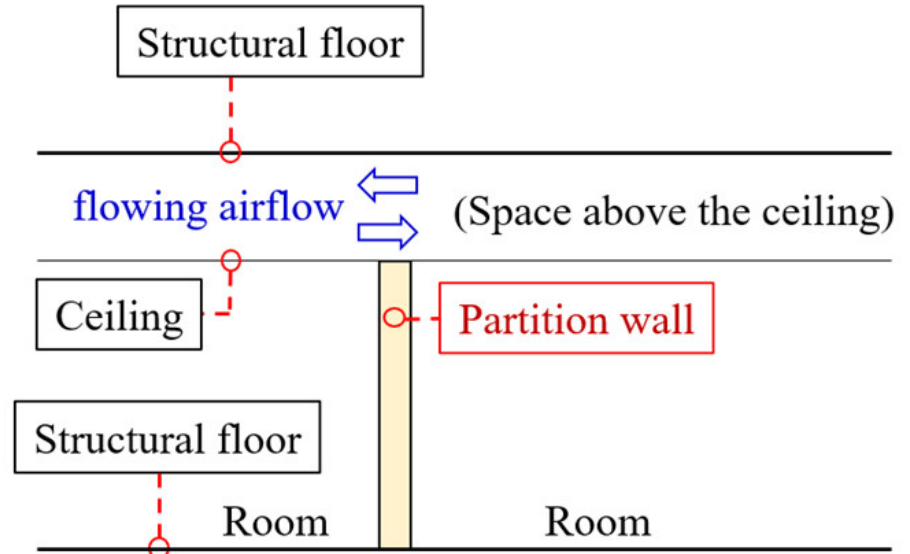
Figure 3. The wall is not connected to the floor structure above.